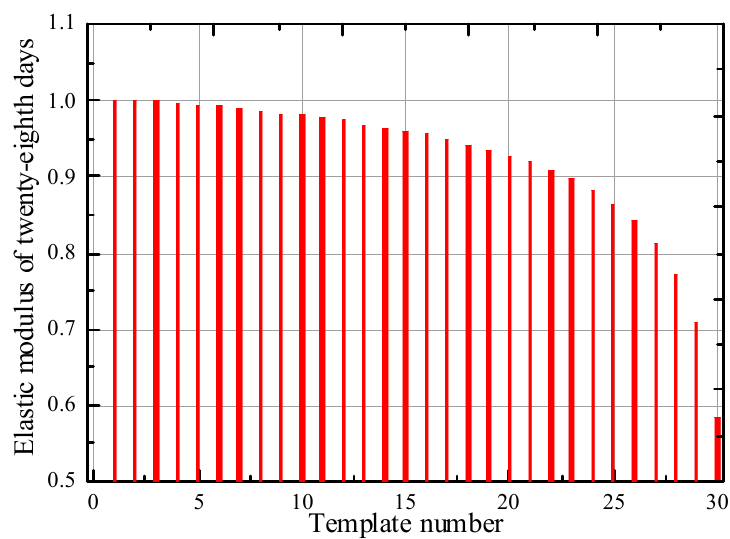
Figure 12. Distribution of elastic modulus of concrete under working condition 2.